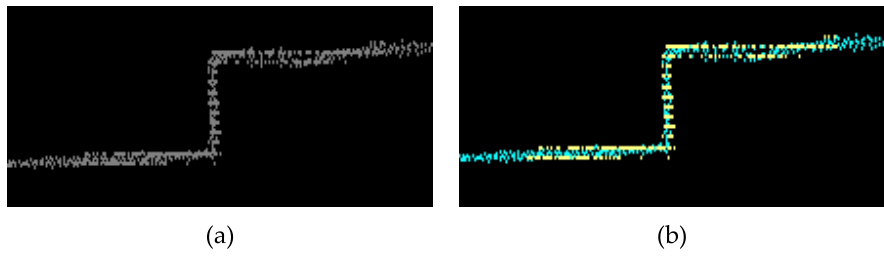
Figure 6. ( a ) Profile of a curb in the measured point cloud and ( b ) the segmented curb, with the detected curb in yellow and the background points in blue.